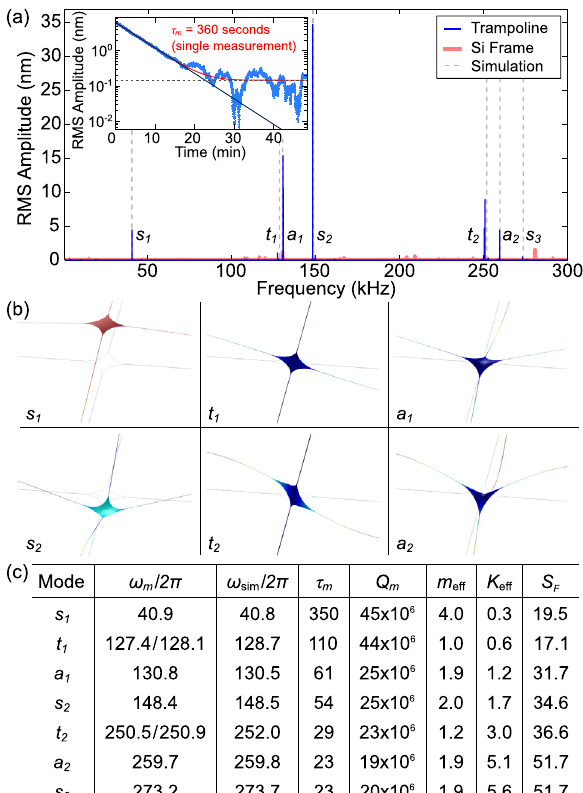
(ng), spring constant K eff eff